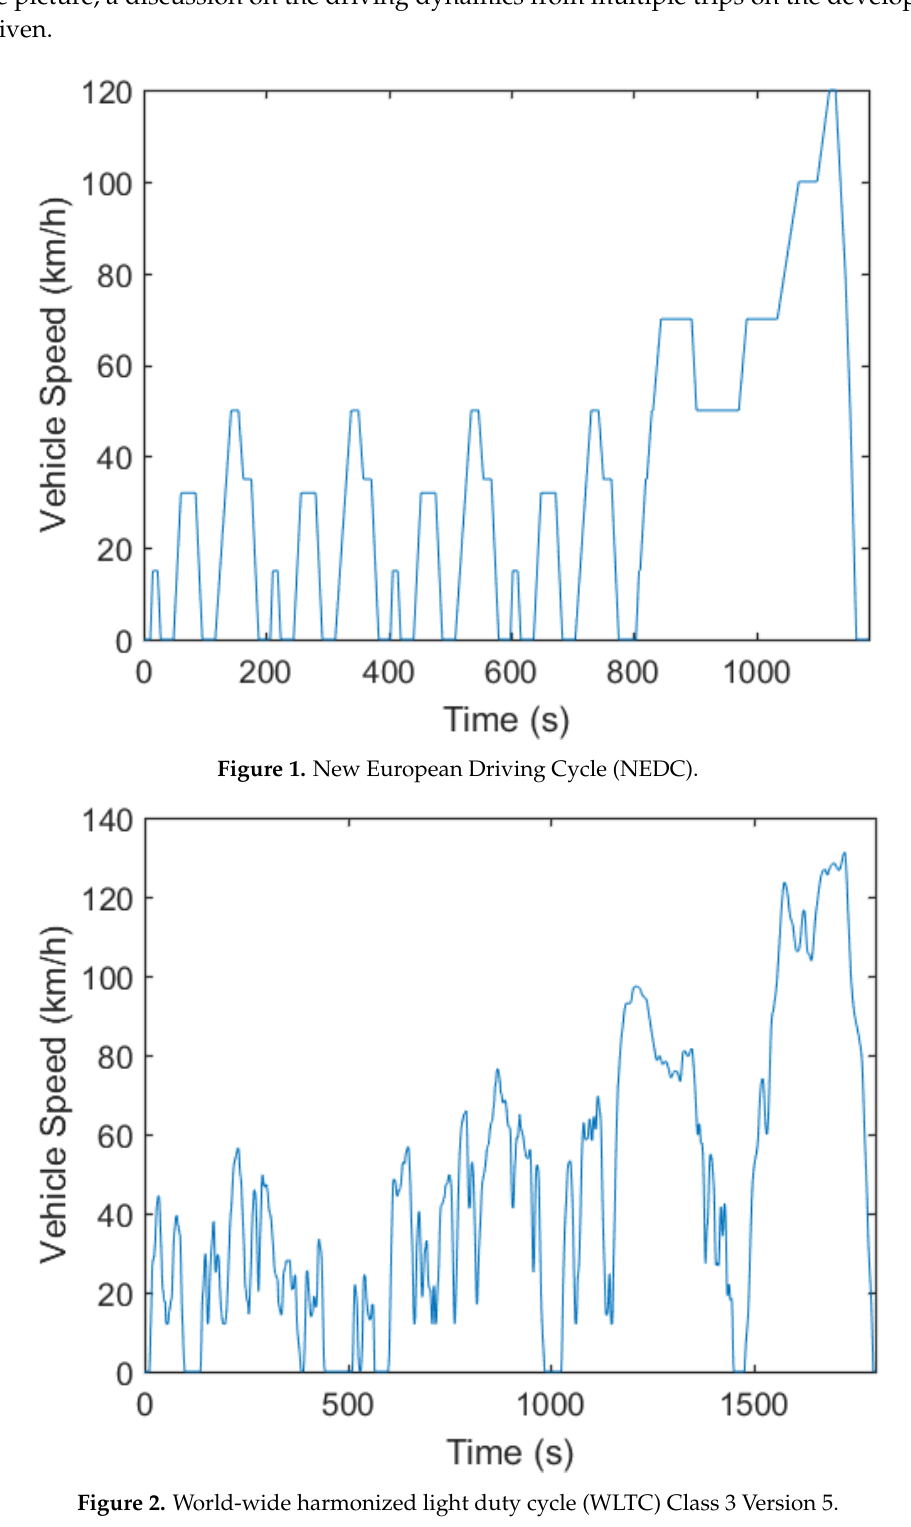
Figure 2. World-wide harmonized light duty cycle (WLTC) Class 3 Version